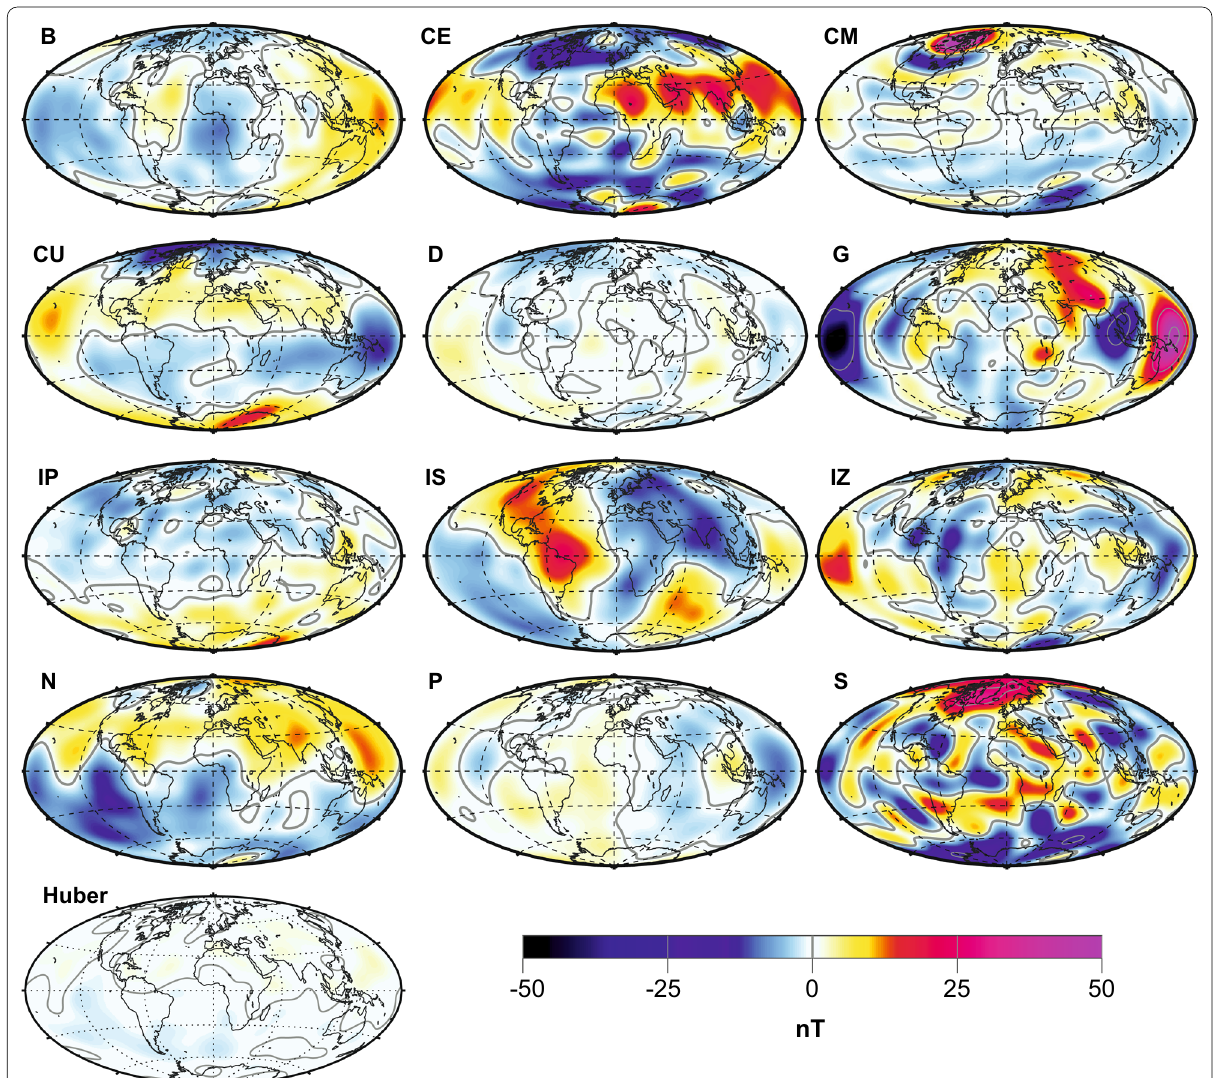
a between the vertical field ( B z ) of the IGRF-2020 candidates and the median model field =